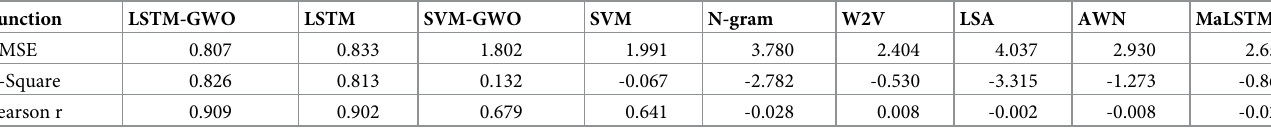
Table 5. Comparison of the proposed model and compared models with experiment 1.